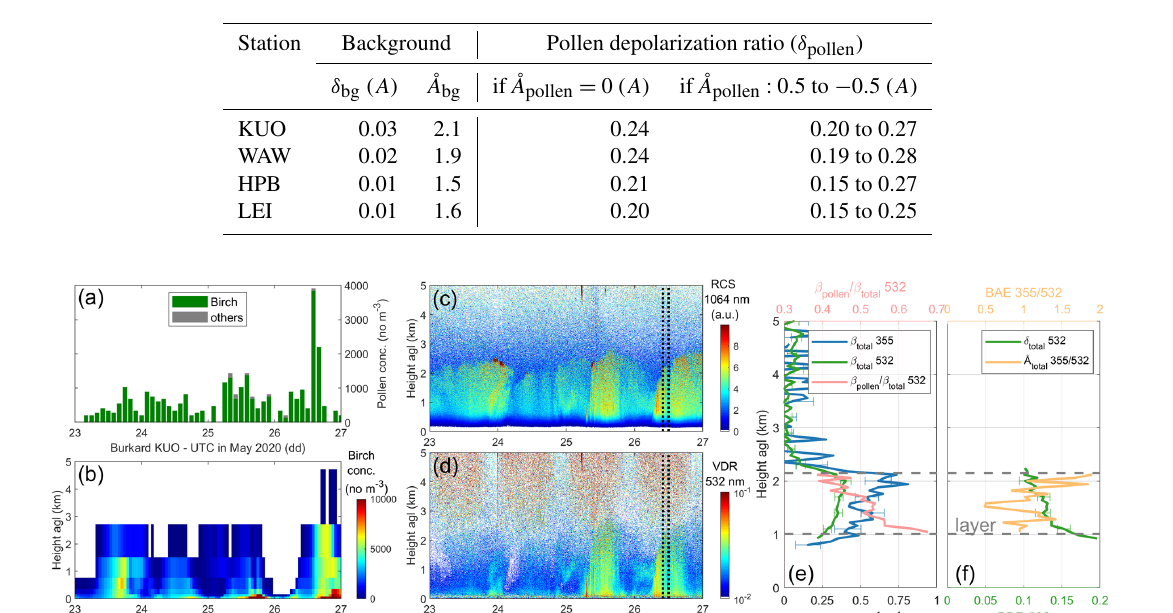
Table 3. Characteristic values of background (bg) and pollen particles for pollen periods of four stations, derived from the regression fitting lines in Fig. 2. δ : depolarization ratio at 532nm. Å : backscatter-related Ångström exponent between 355 and 532nm. “ A ” denotes the assumption.